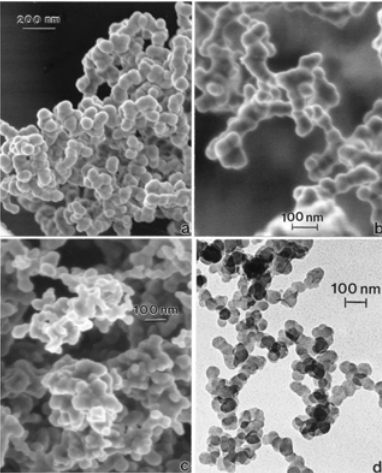
Figure 16: FESEM and TEM images of speciated soot PM. (a) FESEM view of candle soot (CPM). (b) Wood soot (WPM) observed in FESEM. (c) Diesel soot (DPM) observed in FESEM. (d) TEM image of tire soot (TPM). (a) to (c) PM collected on glass fiber filters. PM in (d) collected by thermal precipitation. (From Murr, et al [47]).